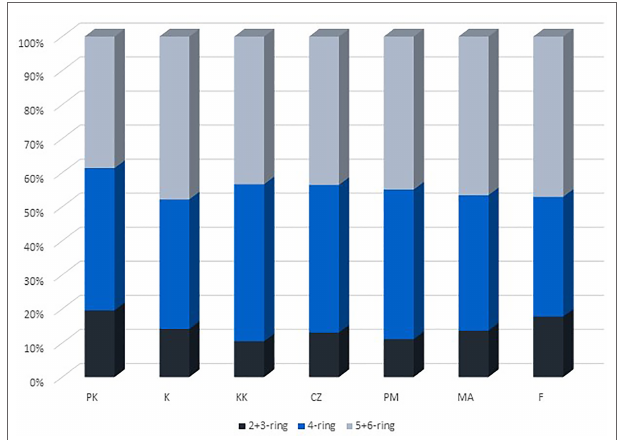
FIGURE 2 | Distribution of PAHs with different number of aromatic rings in sediment samples (average